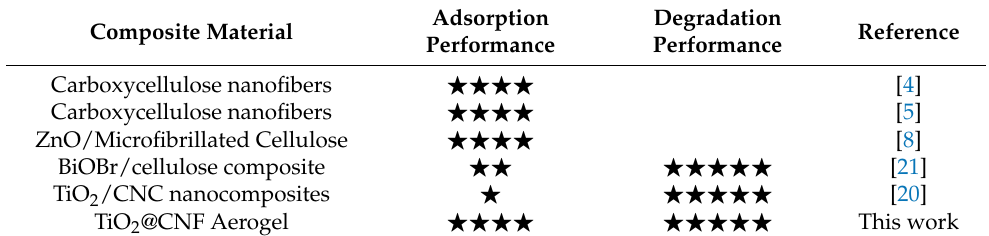
Table 1. Performance comparison of the TiO 2 @CNF Aerogel and cellulose materials in reference.